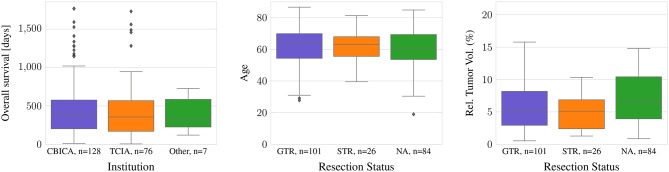
Difference in age and tumor-to-brain volume by resection status, and survival by provenance.